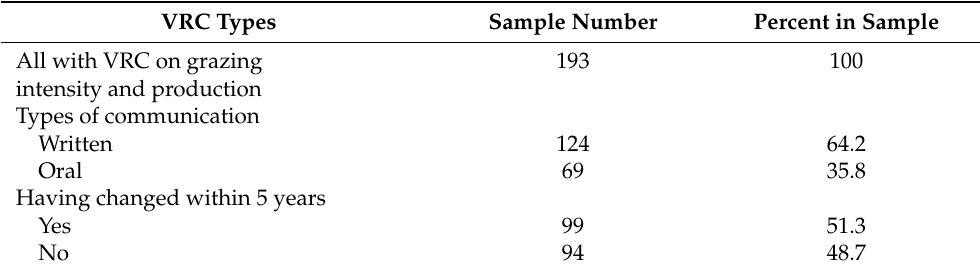
Table 4. Number of herders with VRC in 2018 by different